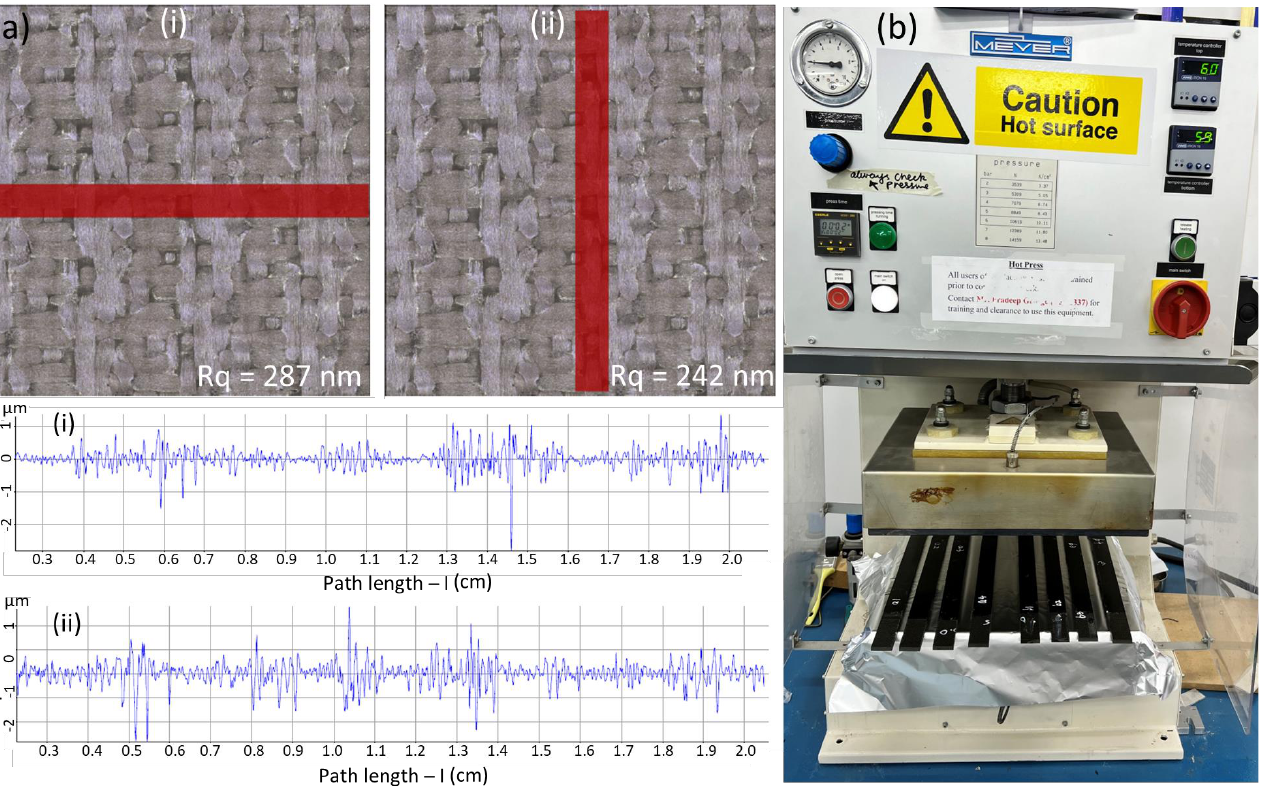
Figure 2. ( a ) Surface roughness profile of the specimens and ( b ) hydraulic press used for the repair of the scarf joints. Note: (i) shows roughness in the x direction and (ii) shows roughness in the y direction.